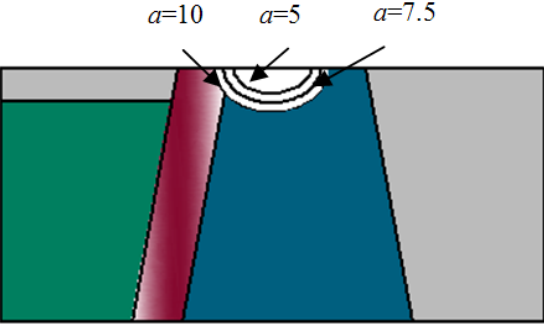
Figure 3: Crack locations and depths in the